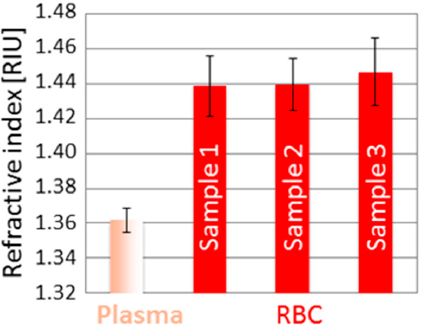
Figure 5. Column bar graph with average and standard deviation values of refractive index obtained for plasma and RBCs from three different samples.